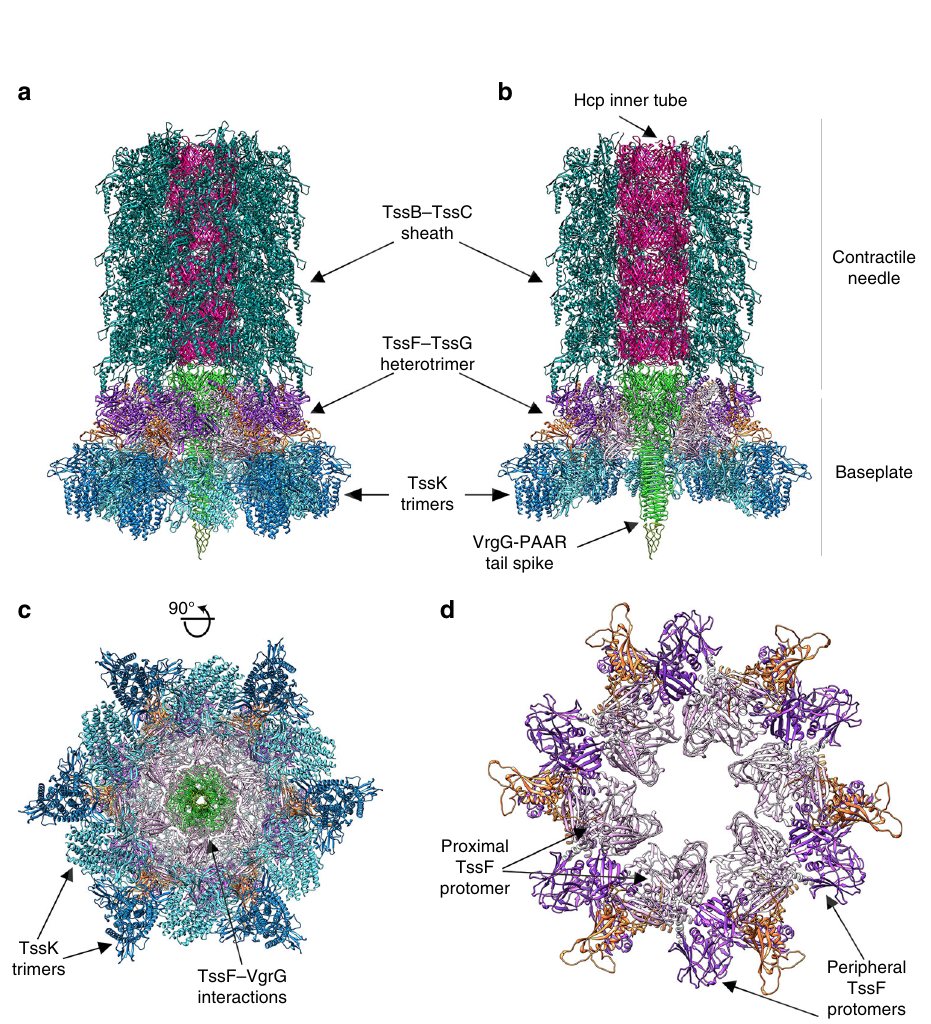
f Bacterial two-hybrid analysis of protein – protein interactions within the EAEC TssK – TssF – TssG complex. BTH101 reporter cells producing the indicated proteins or domains (TssGc: C-terminal domain of TssG, TssGc L1: C-terminal domain of TssG with the Met228Arg, Leu236Arg and Met242Arg substitutions, TssGc L2: C-terminal domain of TssG with Leu308Arg, Leu319Arg and Met325Arg substitutions, and TssK Δ 1 – 17: TssK with deletion of the 17 N -terminal residues) fused to the T18 or T25 domain of the Bordetella adenylate cyclase were spotted on plates supplemented with IPTG and the chromogenic substrate X-Gal. Interaction between the two fusion proteins is attested by the dark blue color of the colony